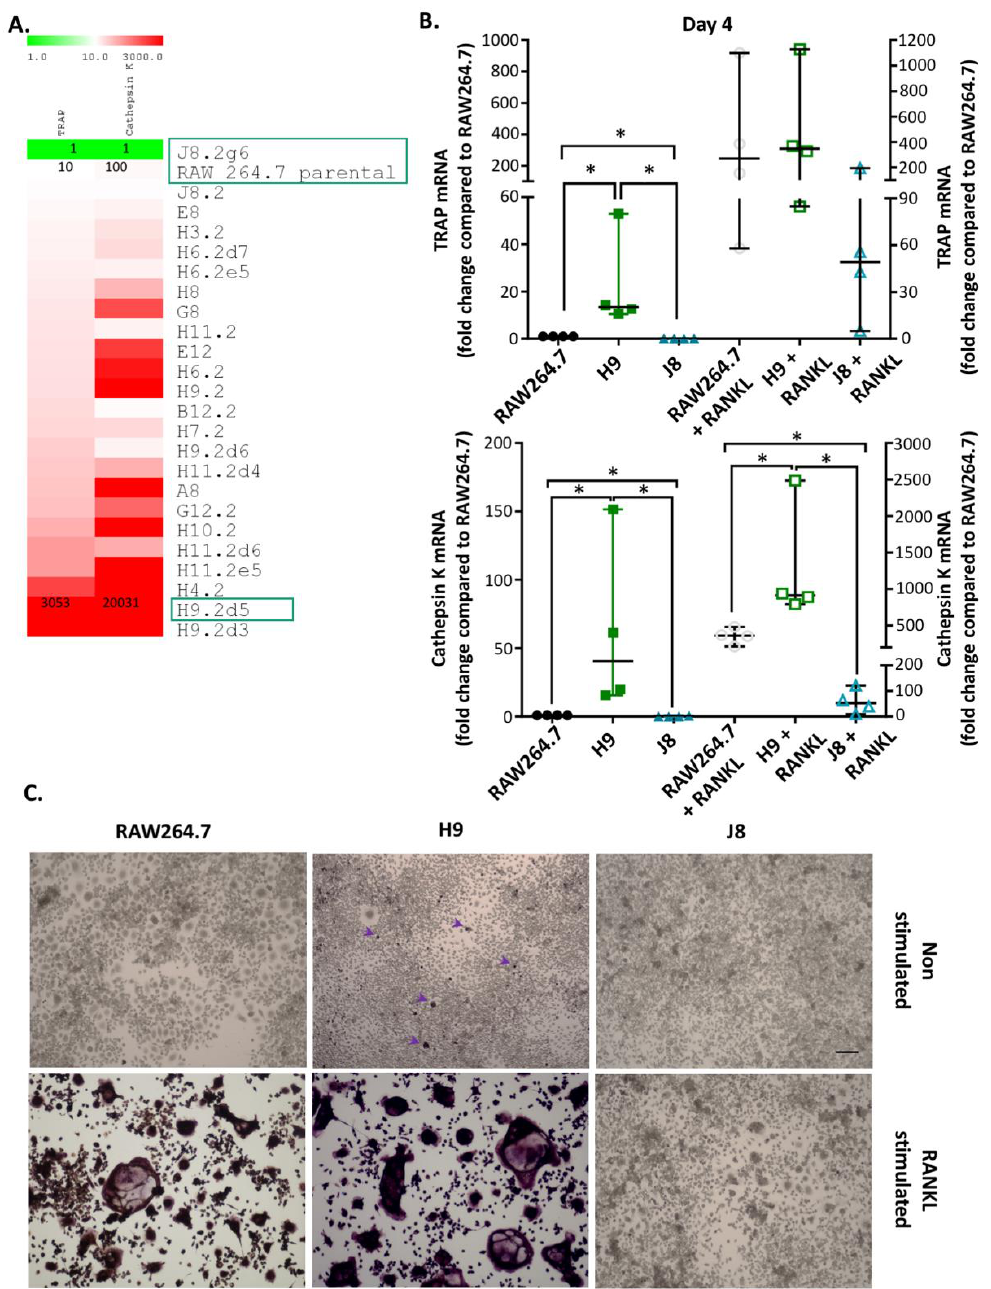
Figure 1. Single cell cloning and osteoclast gene expression screening for the selection of sub-clones. ( A ) Representative heat map of TRAP and CtsK gene expression in RAW264.7 clones using qPCR. ( B ) TRAP and CtsK gene expression in RAW264.7 and sub-clone H9 and J8 +/− 10 ng/mL RANKL for 4 days ( n = 4). Data were analyzed using Mann–Whitney U test. * p < 0.05. Values are given as median +/ − range. ( C ) TRAP activity staining of RAW264.7 and sub-clone H9 and J8 +/ − 10 ng / mL RANKL for 4 days. Arrows = mononuclear TRAP + cells. Arrows point to multinuclear TRAP + cells. Scale bar is 200 µ m and all micrographs have the same magnification.